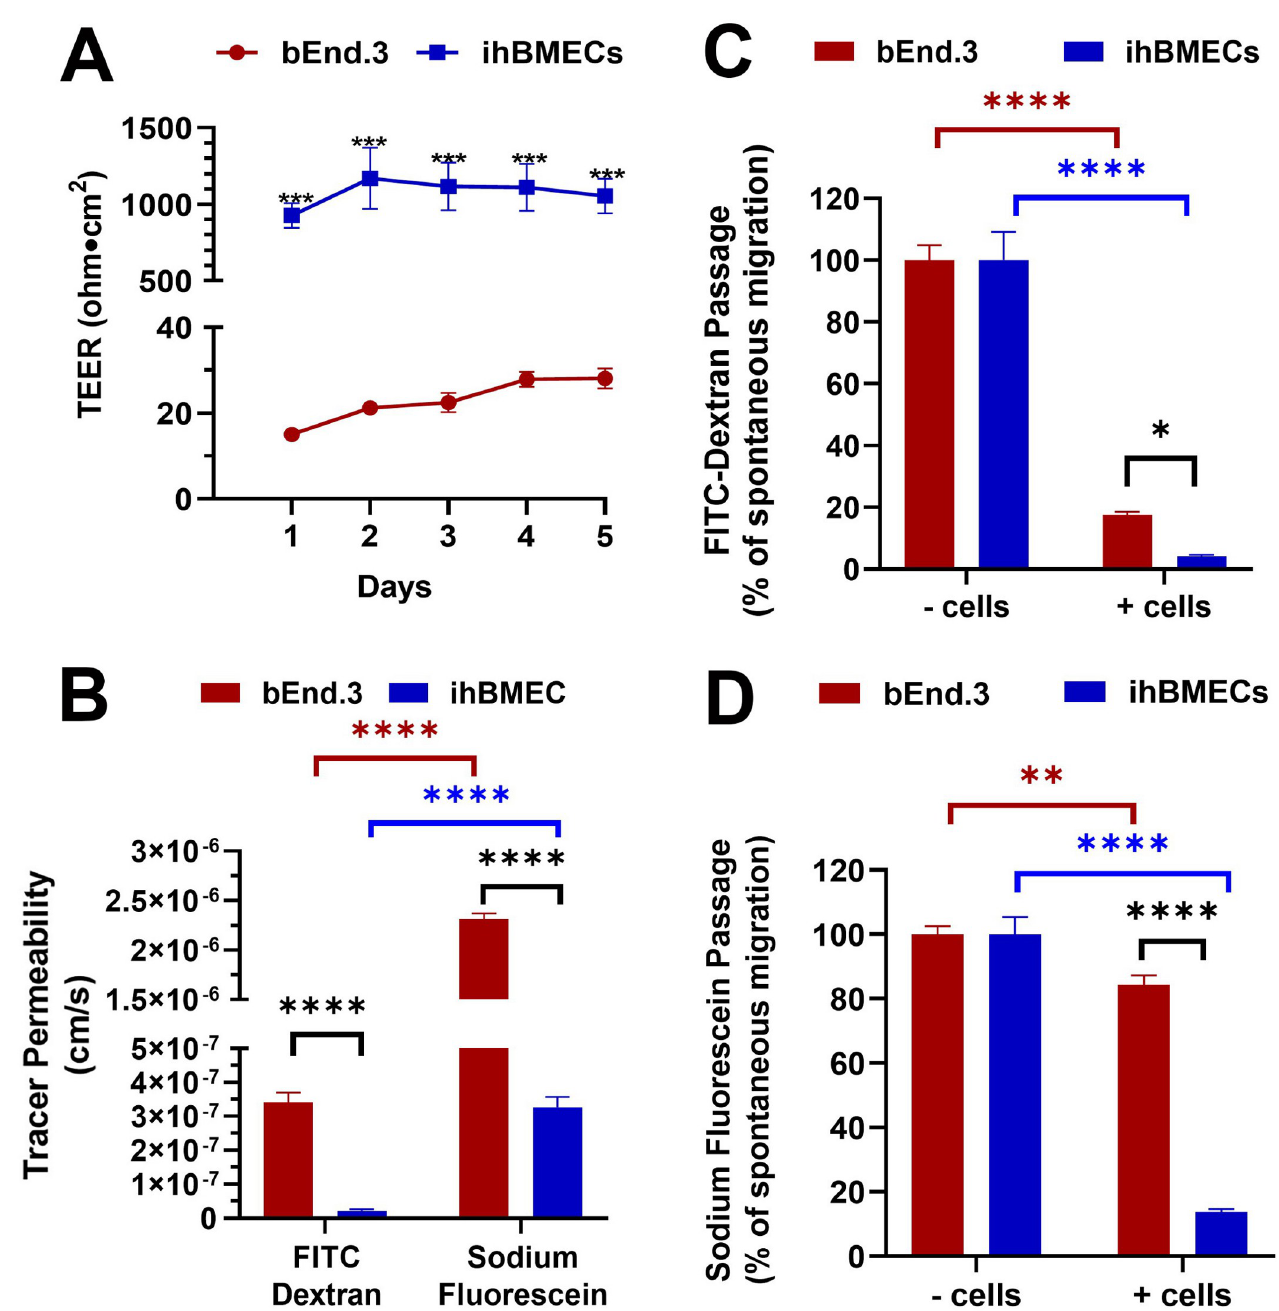
Fig 1. Transendothelial electrical resistance (TEER) and tracer passage. TEER expressed in ohm.cm 2 ( A ). Permeability of FITC-dextran and sodium fluorescein ( B ) across the bEnd.3 and ihBMEC monolayers grown on Transwell inserts. Reduction in the spontaneous passage of FITC-dextran ( C ) and sodium fluorescein ( D ) by the bEnd.3 and ihBMEC monolayers. Spontaneous migration represents the transport of the tracer in the absence of the brain endothelial monolayer. Data are presented as mean ± SEM of n = 3–8 per time point. � p < 0.05, �� p < 0.01, ��� p < 0.001, ���� p < 0.0001, by two-way ANOVA and Holm-Sidak post hoc